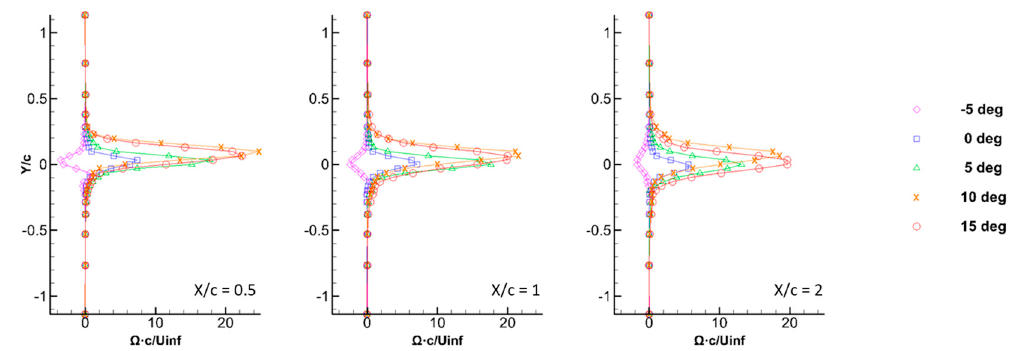
Figure 13. Line plots vorticity for the three measurement planes.